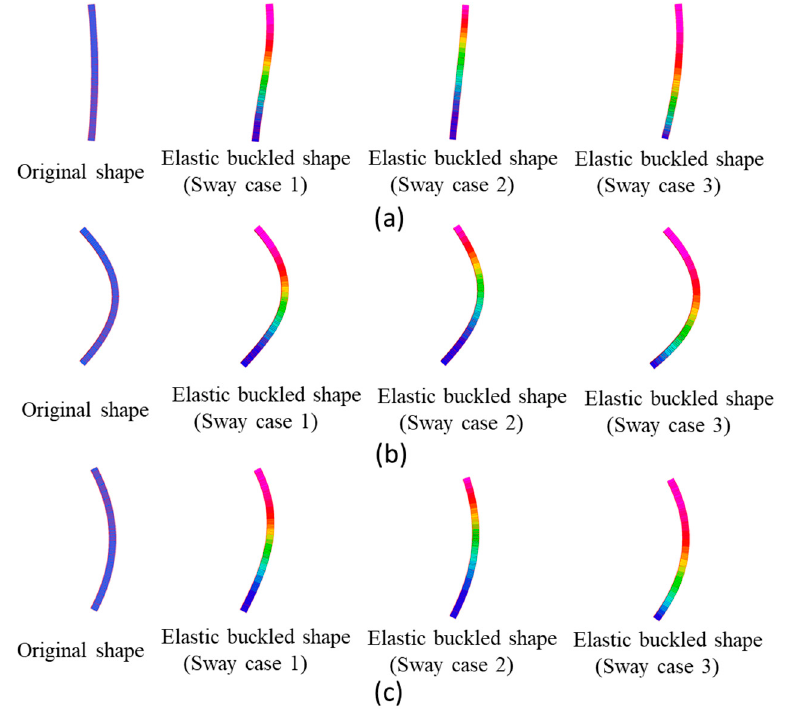
Figure 21. ( a ) The critical elastic buckled shape for the curved column with L/R ratio 0.4; ( b ) the critical elastic buckled shape for the curved column with L/R ratio 1.0; ( c ) the critical elastic buckled shape for the curved column with L/R ratio 1.8.